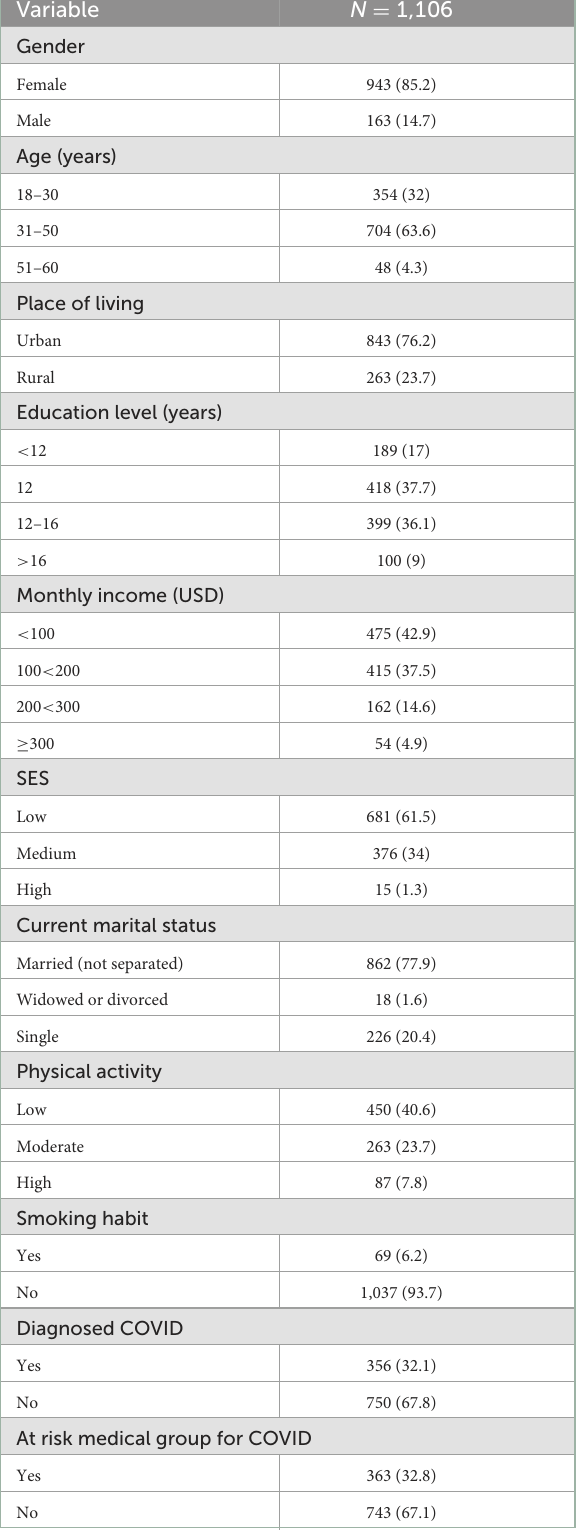
TABLE 1 Socio-demographic characteristics of the participants who filled out the